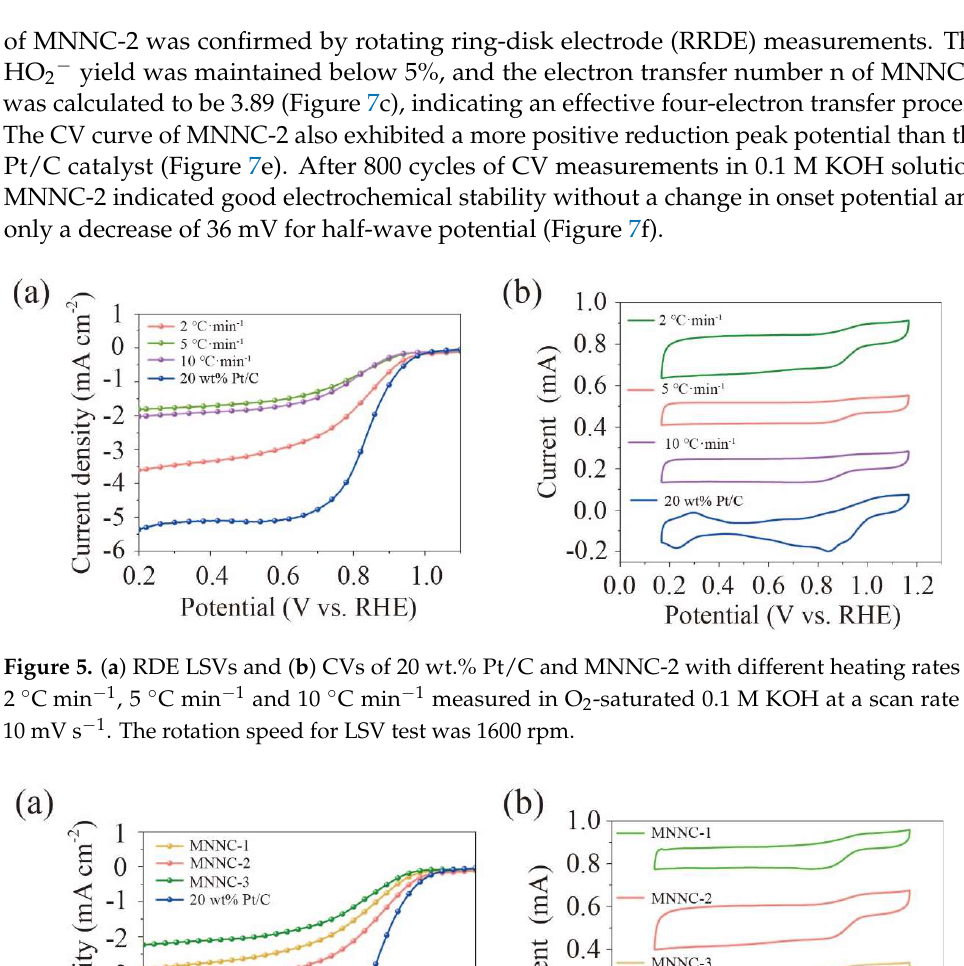
Figure 6. ( a ) RDE LSVs and ( b ) CVs of MNNC-1, MNNC-2, MNNC-3 and 20 wt.% Pt/C in O 2 - saturated 0.1 M KOH at a scan rate of 10 mV s −1 . The rotation speed for LSV test was 1600 rpm. Further investigation of the MNNC-2 electrocatalytic performance was conducted.